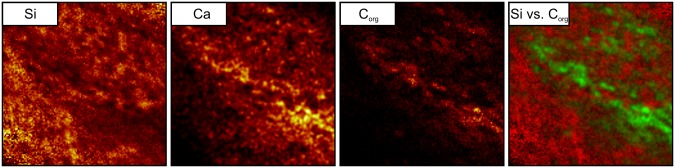
ToF-SIMS ion images of a 300μm × 300μm area of the back chert facies with an organic matter layer in the center.The pixel brightness reflects the signal intensity of (from the left): Si = [Si]+, representing the chert matrix; Ca = sum of [Ca]+, [CaO]+, and [CaOH]+, representing CaCO3; Corg = sum of major hydrocarbon ions [C2H3]+, [C2H5]+, [C3H]+, [C3H2]+, and [C3H3]+, representing organic matter. Pixel brightness in Ca and color coded overlay of Si (red) and Corg (green) is enhanced to increase image contrast.